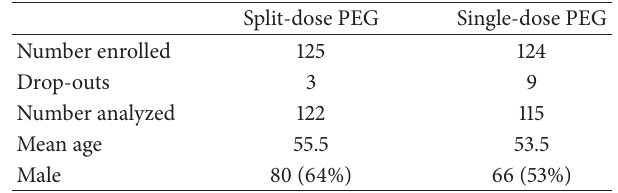
Table 1: Baseline characteristics of the